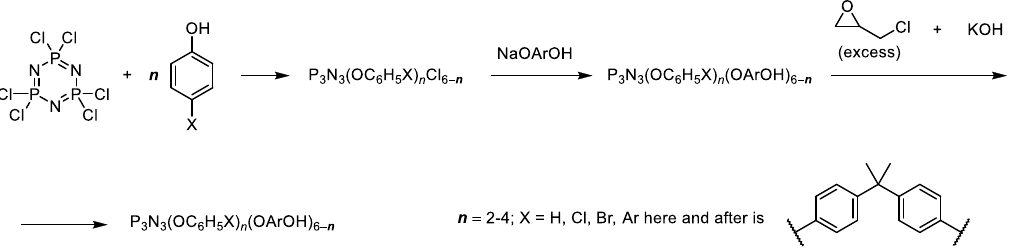
Figure 2. Replacement of the part of the chlorine atoms in chlorophosphazene with monophenol residues in order to increase the content of epoxycyclophosphazenes in a mixture with the organic epoxide [53].